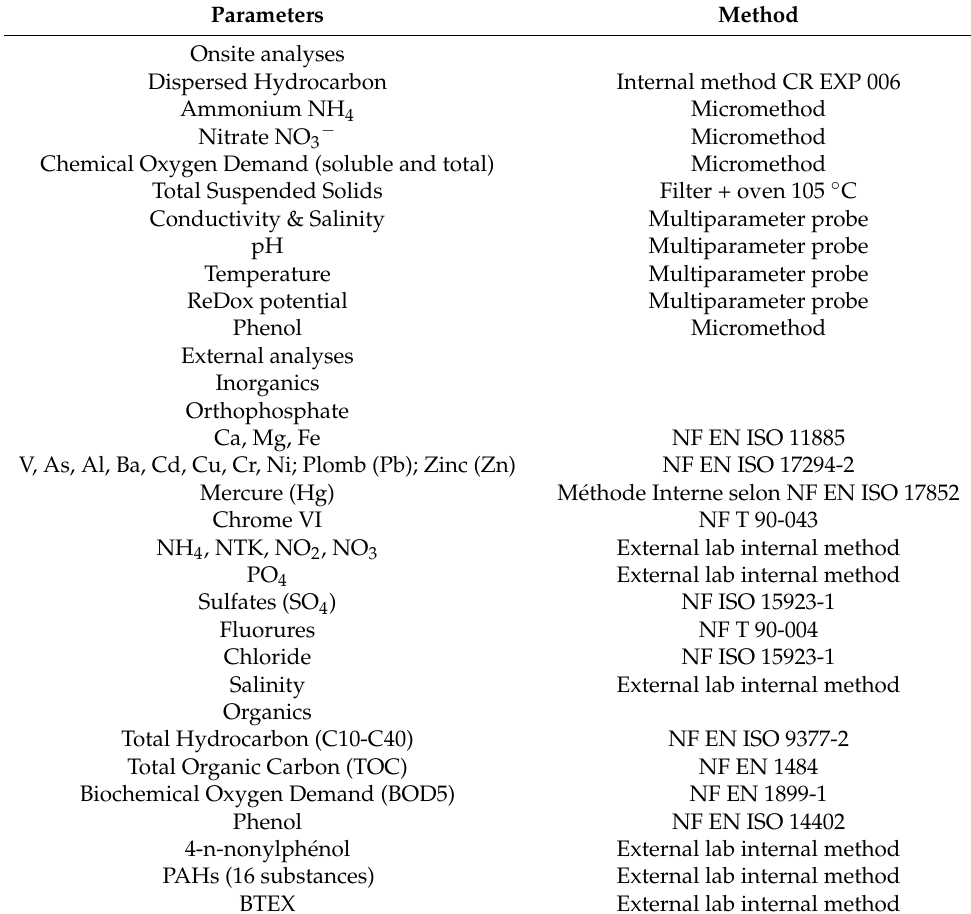
Table 1. List of analyses performed (onsite and